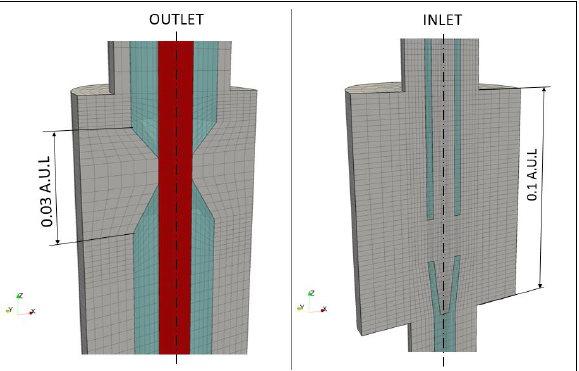
Figure 3. Cutaway views of the mesh around the inlet and the outlet transitions (stainless steel parts in gray, zircaloy parts in red, fluid in